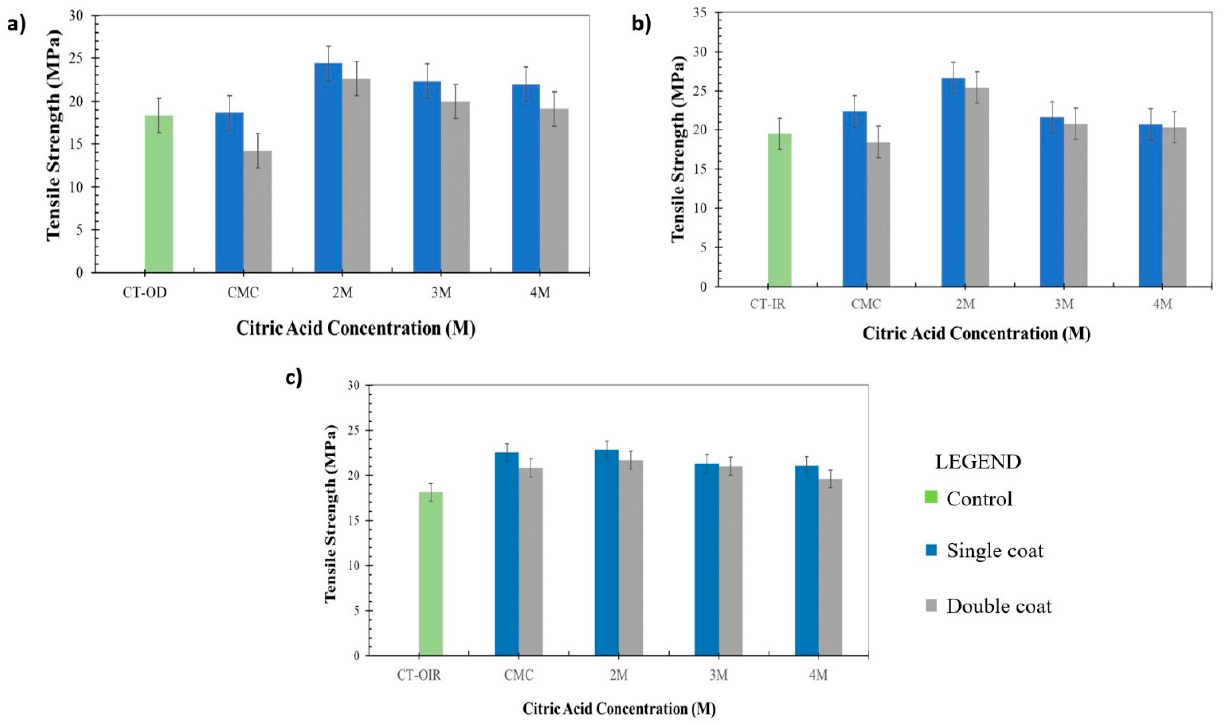
Figure 6. Tensile strength of CT/CMC cross-linked with different CA concentrations dried by ( a ) OD, ( b ) IR, and ( c ) OIR